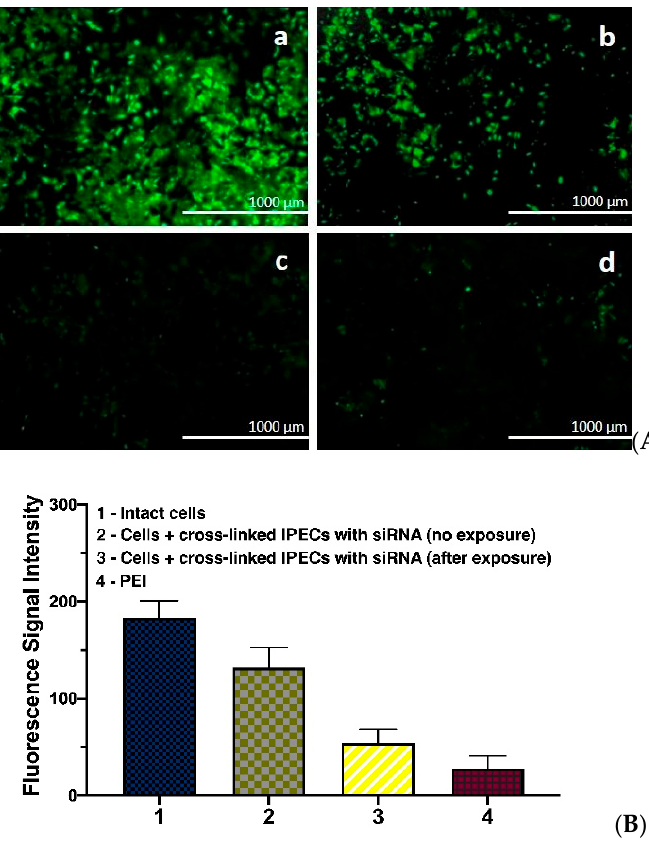
Figure 11. RNA interference by anti-GFP small interfering RNA that was delivered by PLL/Hep IPECs ([Lys–NH 3+ ]:[siRNA–PO 4 − ]:[Hep–SO 3 − ]:[linker] = 1:1:4:0.8) in NIH-3T3 cell line. ( A ) Fluorescence microscopy images of NIH-3T3 cells after transfection with anti-GFP siRNA complexed by IPECs: a —intact cells; b —cells incubated with cross-linked anti-GFP-siRNA / IPECs; c —cells incubated with cross-linked anti-GFP-siRNA/IPECs and subjected to the treatment 5W UV 365 nm LED lamp for 30 min; d —cells incubated with anti-GFP-siRNA/PEI polyplex. ( B ) Flow cytometry detection of GFP fluorescence after co-incubation with anti-GFP siRNA containing complexes. Co-incubation time was 4 h. Mean (± SD), n = 5.